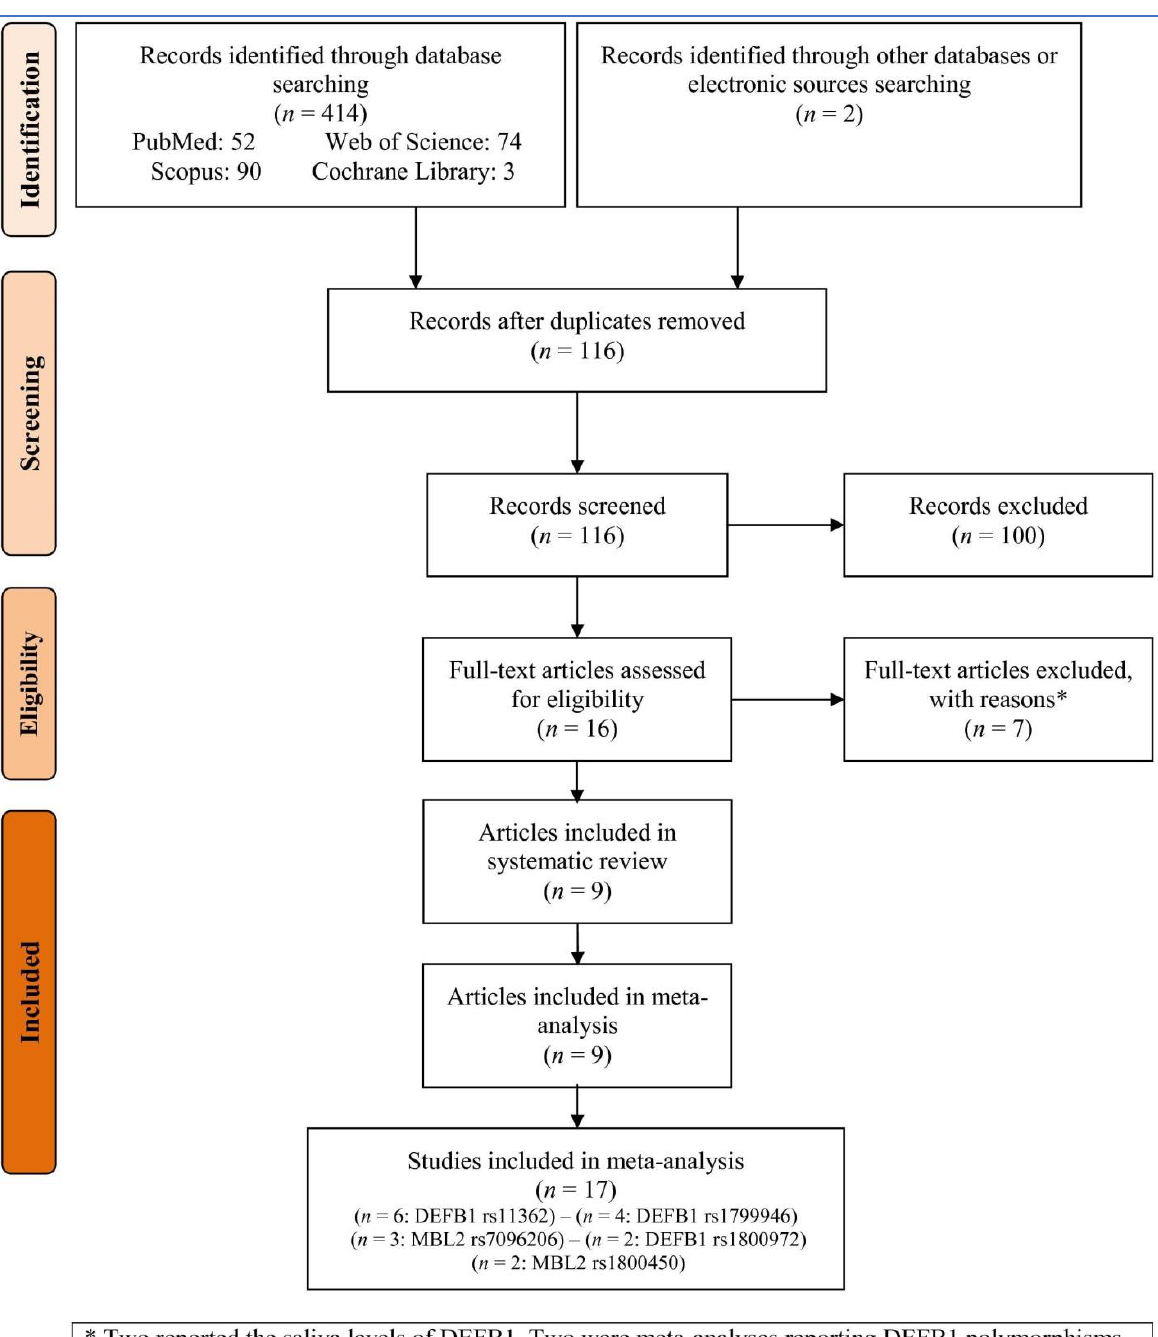
Figure 1. Flowchart of study selection. DEFB1: beta-defensin 1. MBL2: mannose-binding lectin 2.